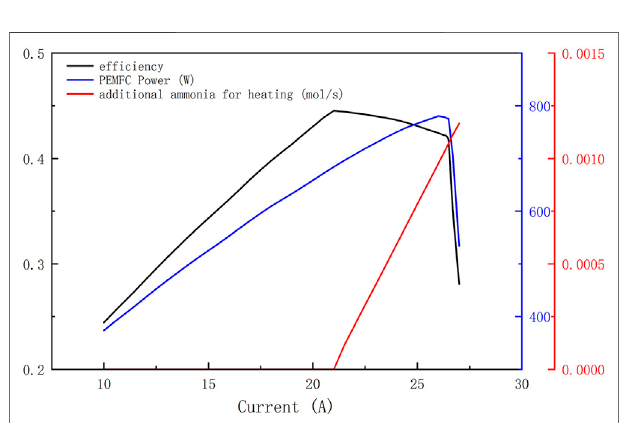
FIGURE 7 | System energy distribution